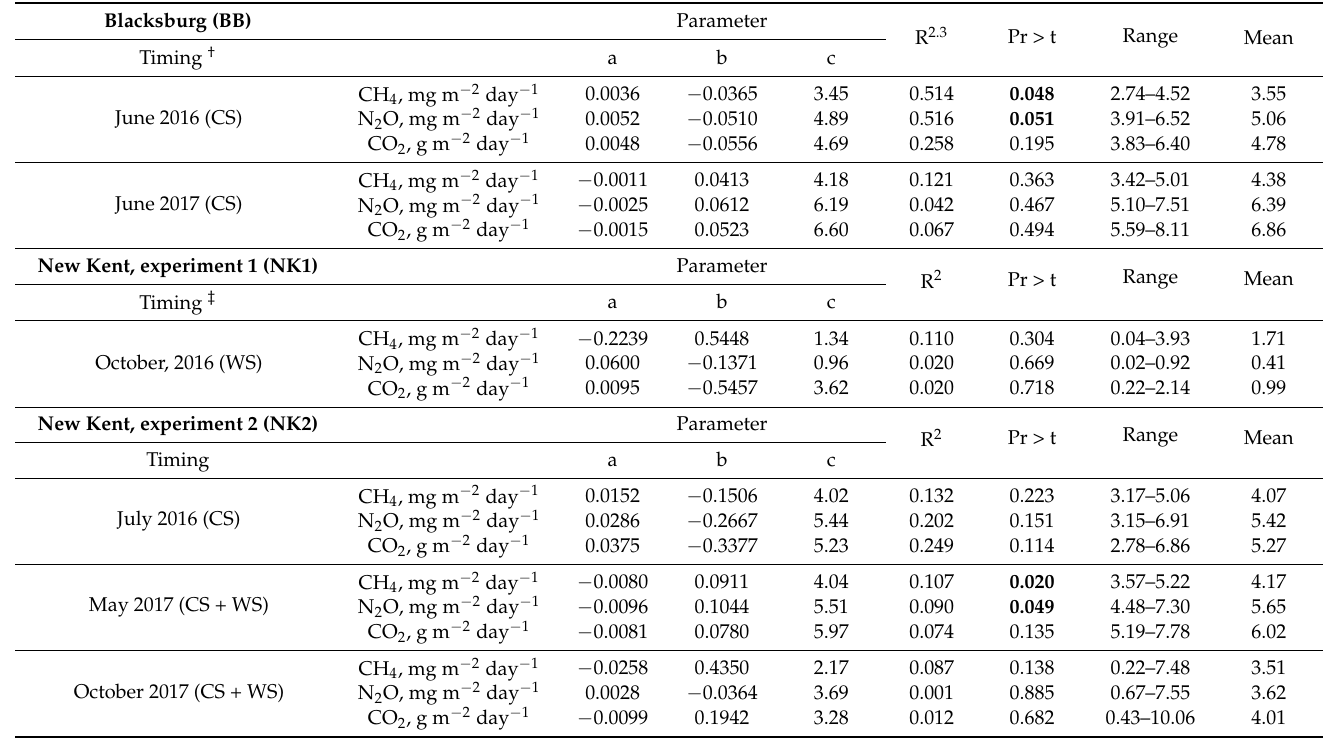
Table 4. Quadratic regression parameters, coefficients of determination (R 2 ), p -values (Pr > t), and range and mean response values for CH 4 (mg m − 2 day − 1 ), N 2 O (mg m − 2 day − 1 ), and CO 2 (g m − 2 day − 1 ) fluxes under different corn stover (CS) and wheat straw (WS) management in 2016 and 2017 in Blacksburg and New Kent,